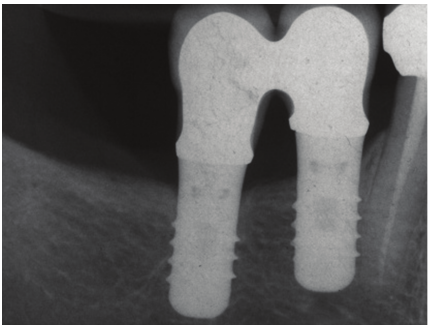
Figure 2: Partial fixed prosthesis supported by short implants (4 . 1 × 8mm), 0 years loading. Periapical